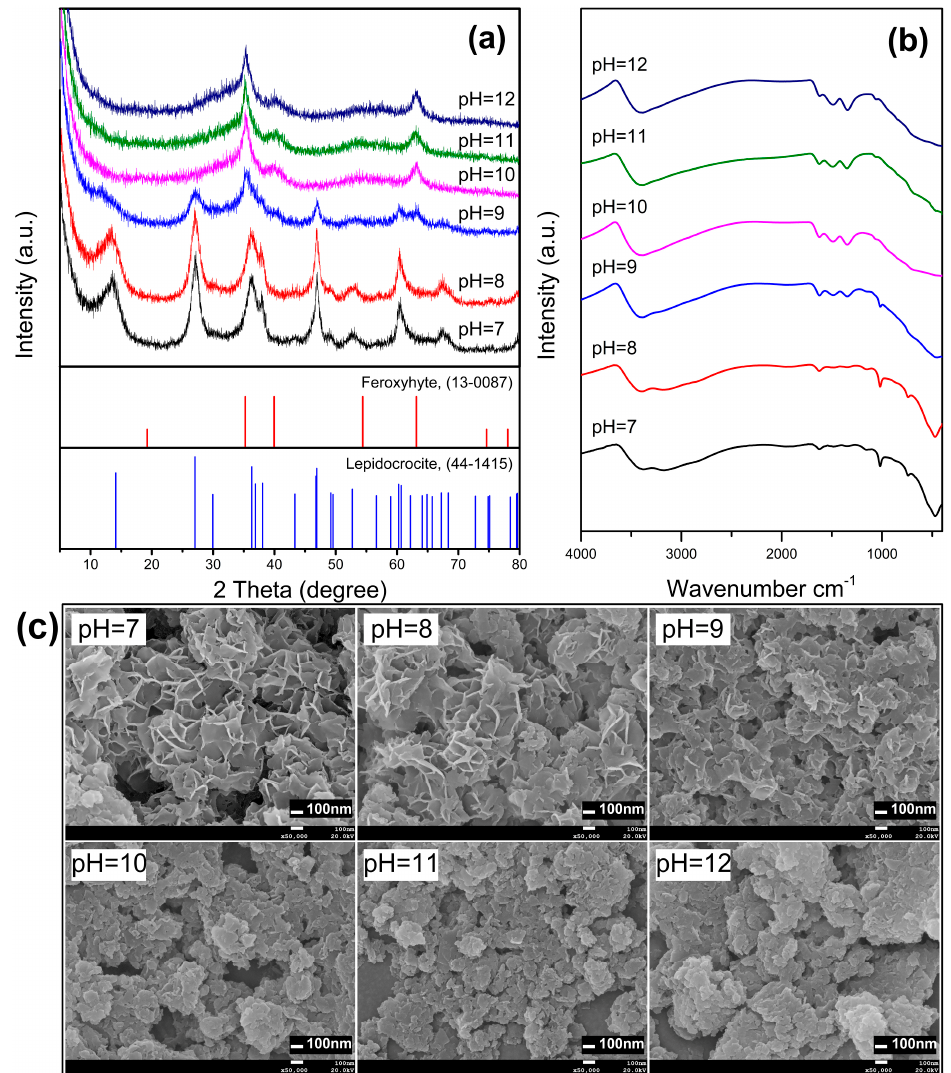
Figure 3. Effect of initial pH on flocculent sludge ( a ) crystal structure; ( b ) surface groups; ( c ) micromorphology, from a 20 min EC treatment applying a current density of 16.7 mA/cm 2 with aeration of 0.2 L/min, using Fe–Fe electrodes at a distance of 2 cm.